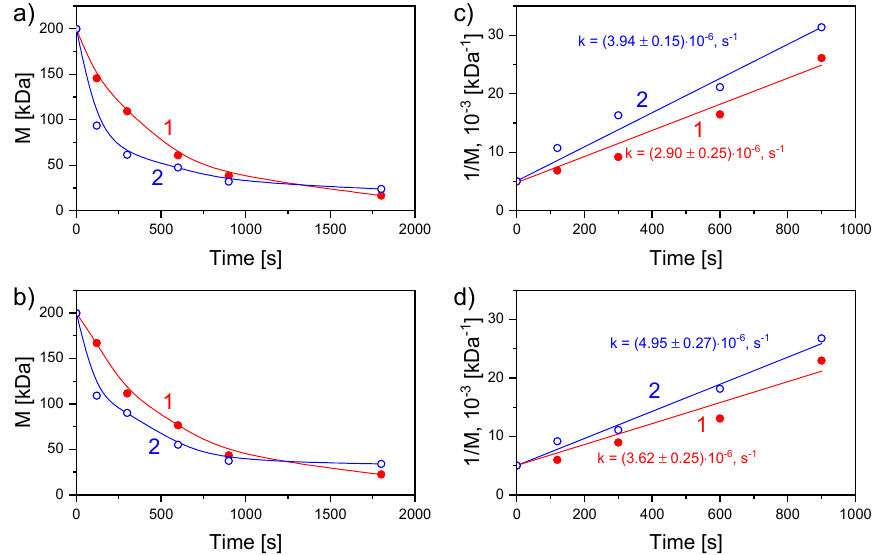
Figure 2. Dependencies of the viscosity average molecular mass and inverse viscosity average molecular mass of chitosan on the time of treatment by discharge with ( a , c ) liquid anode and ( b , d ) liquid cathode. 1, blank chitosan solution; 2, chitosan/AgNO 3 solution.